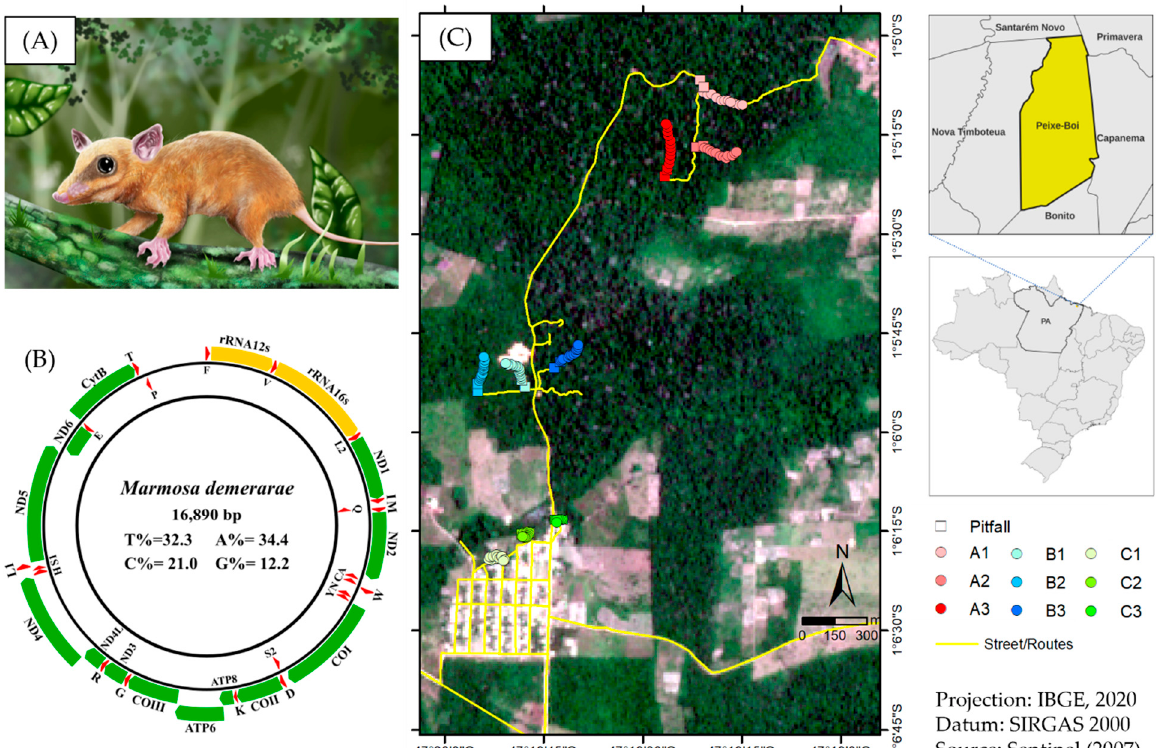
Figure 1. ( A ) Marmosa demerarae digital illustration. ( B ) Structural representation of Marmosa deme- rarae mithocondrial DNA. Internal values indicate the content of the nucleotide bases. Yellow, green, and red blocks indicate rRNA, PCGs, and tRNA, respectively. ( C ) Sample collection sites in the proximities of Ananin village, municipality of Peixe-Boi, Pará State, Brazil.